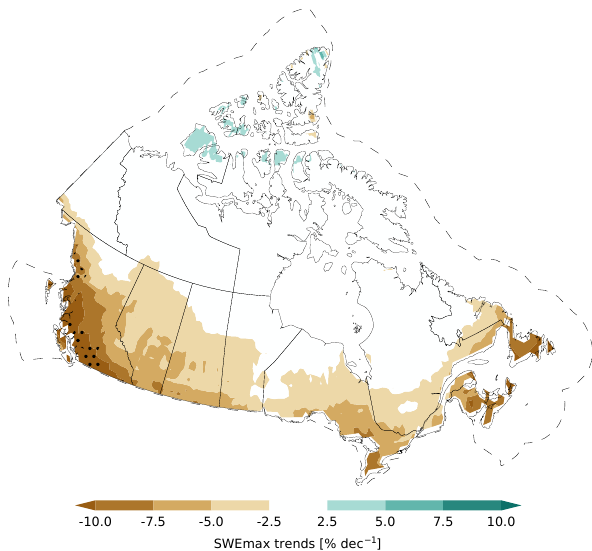
Figure 10. 2020–2050 trends in SWEmax from the CMIP5 ensem- ble. Stippling indicates pointwise significance at the 90th percentile. We show percent change relative to the climatological (1981–2015) mean because there is large variability in SWEmax across the coun- try (high SWE in the Western Cordillera; low SWE in the